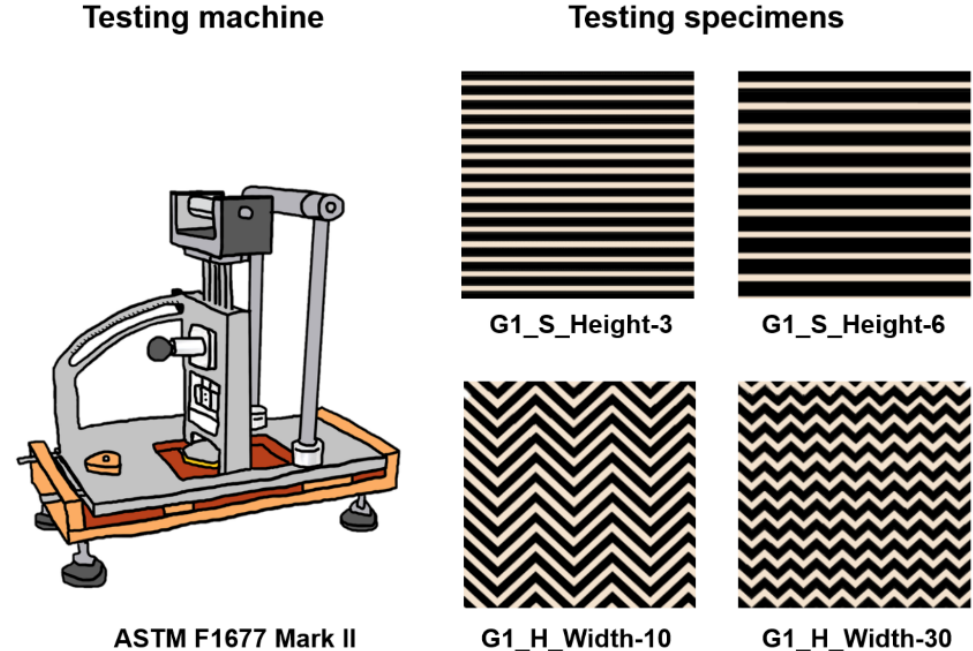
Figure 5. The configuration of the experiment and the specimens.